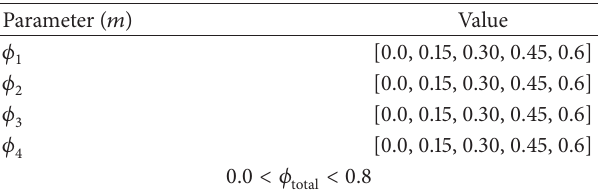
Table 2: Design space for